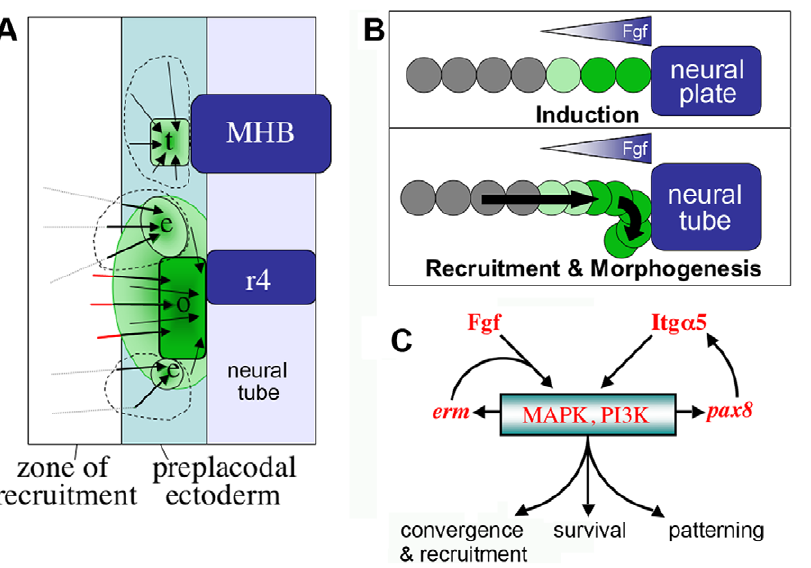
Figure 10. Model for regulation of posterior placode development by itga5 . ( A ) Summary of cell migration during morphogenesis of trigeminal (t), epibranchial (e) and otic (o) placodes. Arrows indicate migration routes of cells tracked in neuroD:EGFP and pax2a:GFP expression domains (green). Dashed circles indicate the general areas from which trigeminal and epibranchial precursors were tracked. Most epibranchial precursors were not detected until relatively late (12.5–13.2 hpf) when they first activated pax2:GFP in a scattered pattern while still lateral to the contiguous domain of expression. We infer these cells originated from more lateral positions within the zone of recruitment (dashed tracks). RFP- positive otic cells were observed to migrate into the pax2a:GFP domain from nearby in the zone of recruitment (red tracks) between 11.7–12.5 hpf. Positions of the midbrain-hindbrain border (MHB) and rhombomere 4 (r4) are indicated. ( B ) A model for recruitment of otic/epibranchial cells. An initial otic domain (green) is induced by dorsally expressed Fgfs. Subsequently, itga5 -dependent medial migration drives convergence of the otic field and draws new cells into range of inductive signaling. ( C ) Model for itga5 in reinforcing Fgf signaling. Erm helps mediate Fgf signaling, which begets more erm expression. Fgf also activates pax8 , which stimulates upregulation of itga5 in the otic/epibranchial domain, further reinforcing Fgf signaling. Fgf acts primarily through the MAPK and PI3K pathways, and Itga5 facilitates these pathways through a variety of mechanisms (see text for details). Together these functional interactions control directed cell migration, cell survival, and gene expression within the otic/epibranchial